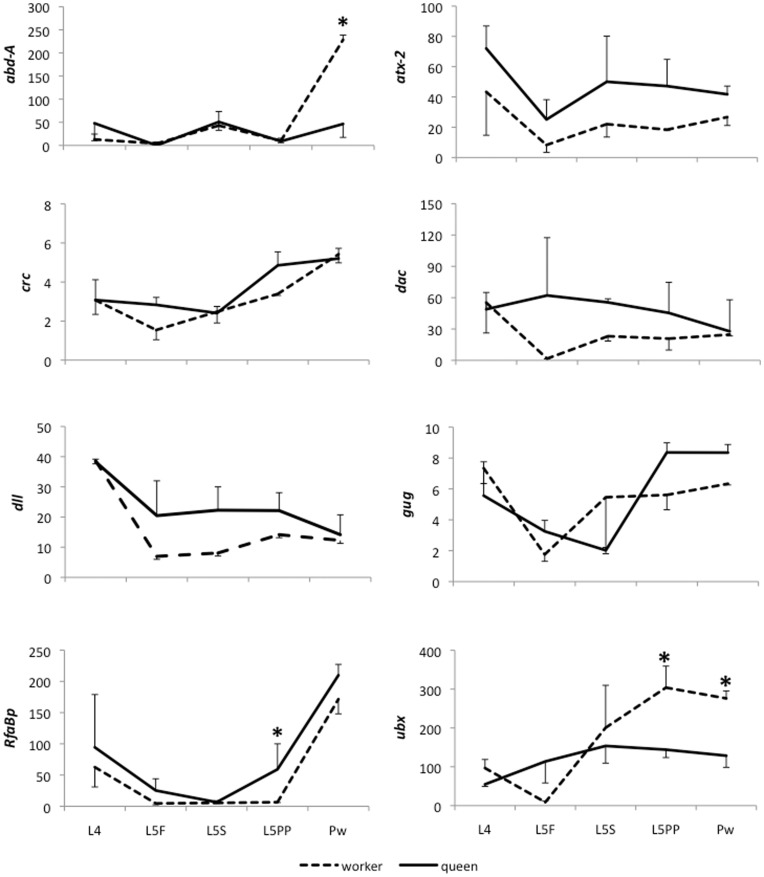
Transcriptional pattern of abdominal-A, ataxin-2, cryptocephal, dachshund, distal-less, grunge, Retinoic and fat acid Binding protein and ultrabithorax during leg development in A. mellifera castes.Ordinates represent relative transcript levels assessed by qRT-PCR. Data were normalized by ribosomal protein-49. Three biological samples were analyzed in technical duplicates. L4, L5F and L5S: larval stages; L5PP: pre-pupae; Pw: white-eyed pupae; *: significant statistical differences between castes (P<0.01).